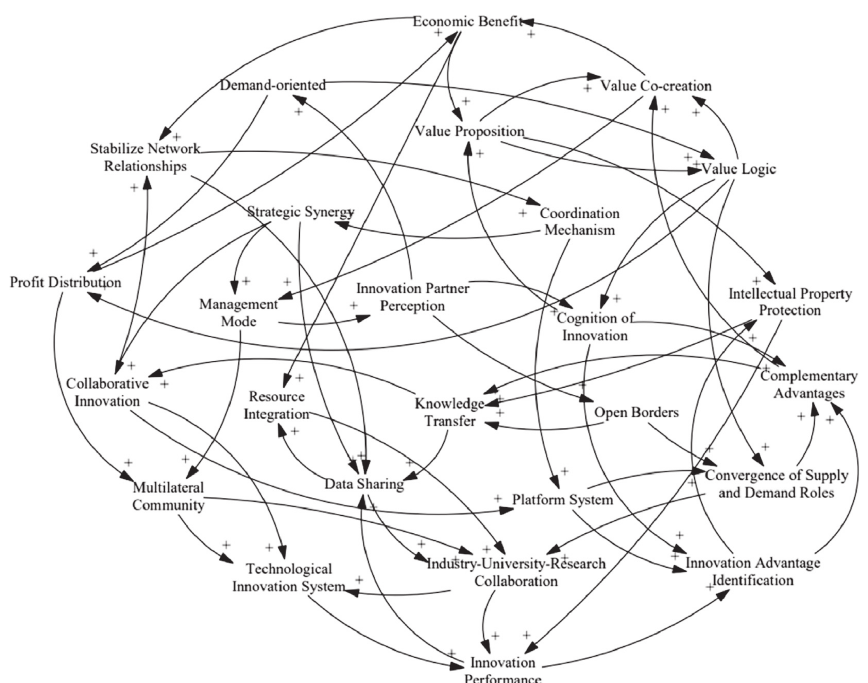
Figure 2: System causal cycle